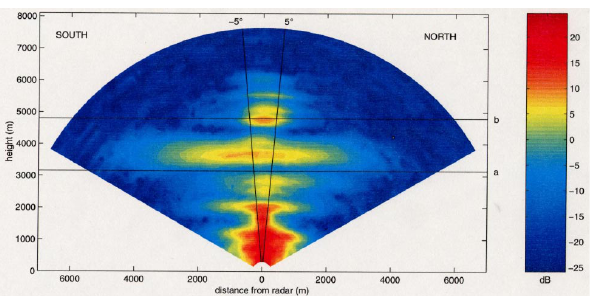
Fig. 2. 2D Map of signal-to-noise ratio obtained in a zonal plan over a 10 minute integration with the Provence radar using a Sequential Post Beam Steering (SPBS) technique. The half-power beamwidth is indicated by the radial lines at − 5 and + 5 degrees. The structure observed around the 4.8km altitude clearly indicates a strong as- pect sensitive echoing layer. Around 3.5km, a less aspect sensitive echoing layer is also observed with a maximum off the zenith. The decrease in reflectivity at low elevation angles results from the loss of sensitivity of the radar (after H´elal et al.,